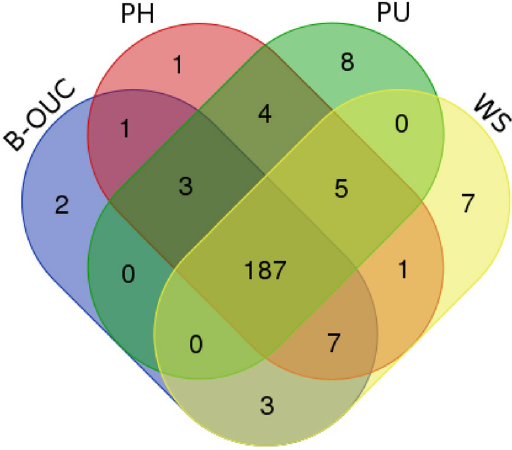
Figure 3. Venn diagram of genes gained and lost among the Bangiophyceae plastomes. PU, Porphyraumbilicalis ; PH, Pyropia haitanensis ; B-OUC, ‘Bangia’ sp . OUCPT-01; WS, Wildemania schizophylla